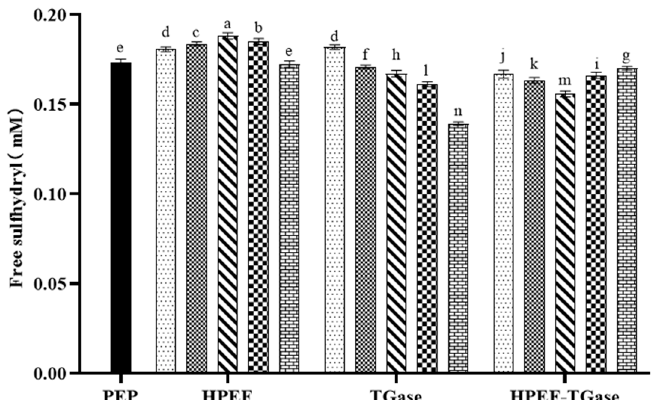
Foods 2023 , 12 , x FOR PEER REVIEW 6 of 21 6 of 21 6 of 21 Figure 1. The effects of HPEF (500, 1000, 1500, 2000, and 2500 V/cm) addition, TGase (0.25, 0.5, 1, 2, Figure 1. The effects of HPEF (500, 1000, 1500, 2000, and 2500 V/cm) addition, TGase (0.25, 0.5, 1, 2, sulfhydryl groups of PEP. : representative control group PEP. In the first group, and 4%), and compound treatment (HPEF-500, 1000, 1500, 2000, 2500 V/cm; 1% TGase) on the free and 4%), and compound treatment (HPEF-500, 1000, 1500, 2000, 2500 V/cm; 1% TGase) on the free sulfhydryl groups of PEP. : representative control group PEP. In the first group, represent HPEF-PEP of 500, 1000, 1500 2000, and 2500 V/cm, respectively. In the sec- sulfhydryl groups of PEP. : representative control group PEP. In the first group, sulfhydryl groups of PEP. : representative control group PEP. In the first group, sulfhydryl groups of PEP. : representative control group PEP. In the first group, represent HPEF-PEP of 500, 1000, 1500 2000, and 2500 V/cm, respectively. In the sec- ond group, represent TGase-PEP of 0.25, 0.5, 1, 2, and 4%, respectively. In the third represent HPEF-PEP of 500, 1000, 1500 2000, and 2500 V/cm, respectively. In the second group, represent HPEF-PEP of 500, 1000, 1500 2000, and 2500 V/cm, respectively. In the sec- represent HPEF-PEP of 500, 1000, 1500 2000, and 2500 V/cm, respectively. In the sec- group, represent HPEF-TGase-PEP treatments of HPEF-500, 1000, 1500, 2000, and ond group, represent TGase-PEP of 0.25, 0.5, 1, 2, and 4%, respectively. In the third ond group, represent TGase-PEP of 0.25, 0.5, 1, 2, and 4%, respectively. In the third ond group, represent TGase-PEP of 0.25, 0.5, 1, 2, and 4%, respectively. In the third represent TGase-PEP of 0.25, 0.5, 1, 2, and 4%, respectively. In the third group, 2500 V/cm, respectively, with 1% TGase. The average particle size group and the solubility are the group, represent HPEF-TGase-PEP treatments of HPEF-500, 1000, 1500, 2000, and group, represent HPEF-TGase-PEP treatments of HPEF-500, 1000, 1500, 2000, and group, represent HPEF-TGase-PEP treatments of HPEF-500, 1000, 1500, 2000, and represent HPEF-TGase-PEP treatments of HPEF-500, 1000, 1500, 2000, and 2500 V/cm, same as the free sulfhydryl. The different lowercase letters indicate a significant difference between 2500 V/cm, respectively, with 1% TGase. The average particle size group and the solubility are the 2500 V/cm, respectively, with 1% TGase. The average particle size group and the solubility are the 2500 V/cm, respectively, with 1% TGase. The average particle size group and the solubility are the respectively, with 1% TGase. The average particle size group and the solubility are the same as groups ( p < 0.05). same as the free sulfhydryl. The different lowercase letters indicate a significant difference between same as the free sulfhydryl. The different lowercase letters indicate a significant difference between same as the free sulfhydryl. The different lowercase letters indicate a significant difference between the free sulfhydryl. The different lowercase letters indicate a significant difference between groups groups ( p < 0.05). groups ( p < 0.05). groups ( p < 0.05). ( p <